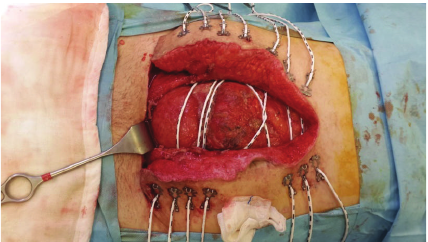
Figure 8: Applied ABRA is seen.